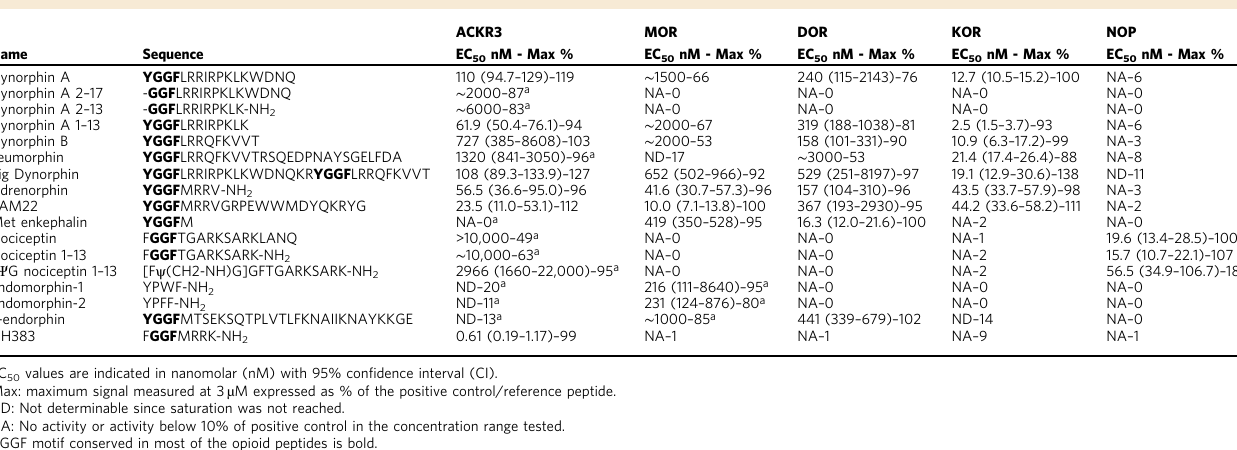
Table 1 Sequences of opioid peptides and their activity in β -arrestin-1